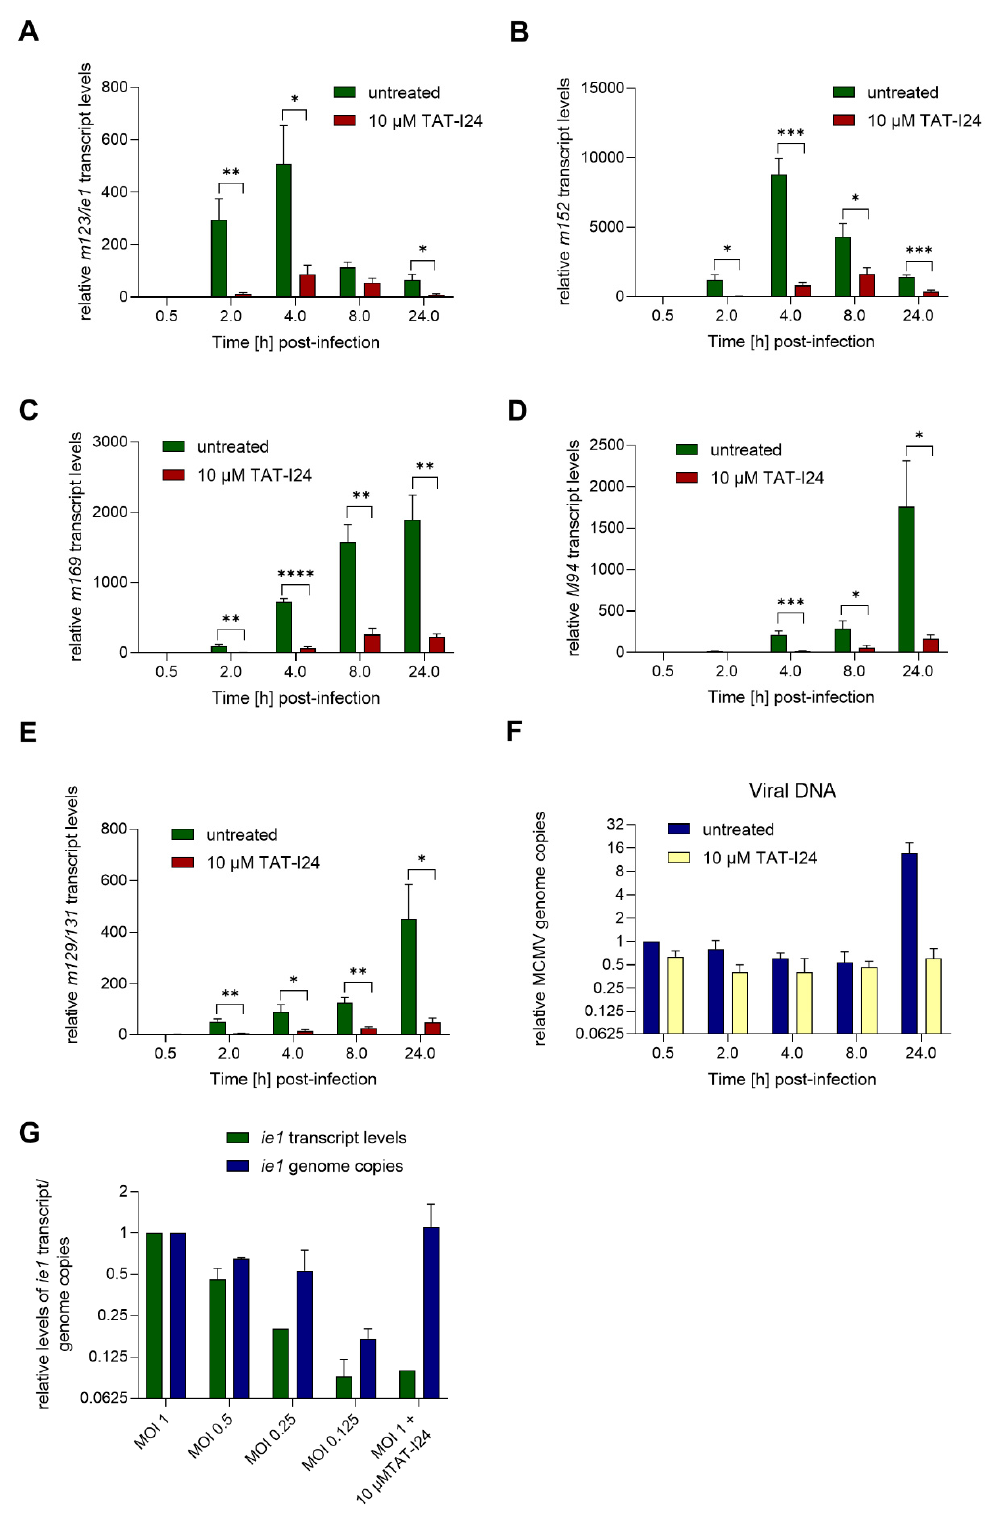
Figure 2. MCMV viral gene transcript levels relative to the housekeeping gene Gapdh in NIH/3T3 cells infected with MCMV (MOI 1) in the absence or presence of 10 µ M TAT-I24. Fold change of transcript levels (mean ± standard error of the mean) from four independent experiments is shown ( A , m123/ie1 ; B , m152 ; C , m169 ; D , M94 ; E , m129/131 ). Multiple t-test was used for statistical analysis; * statistically significant at p ≤ 0.05; ** statistically significant at p ≤ 0.01, *** statistically significant